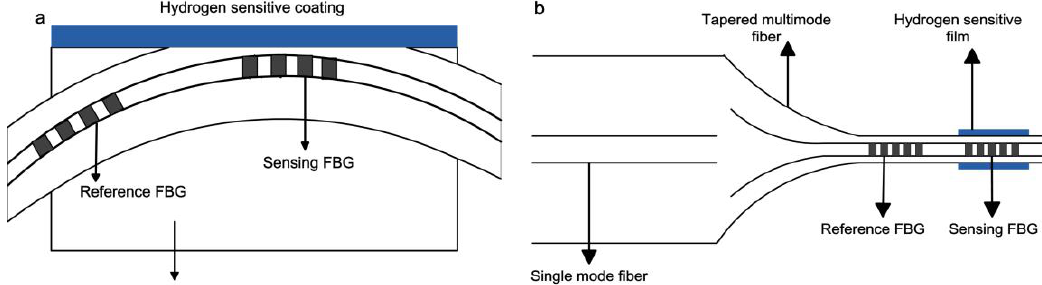
Figure 3. ( a ) Side-polished FBG (SPFBG) hydrogen sensor fixed on quartz substrate [27]; ( b ) Micro-FBG (MFBG) hydrogen sensor based on tapered multimode fiber